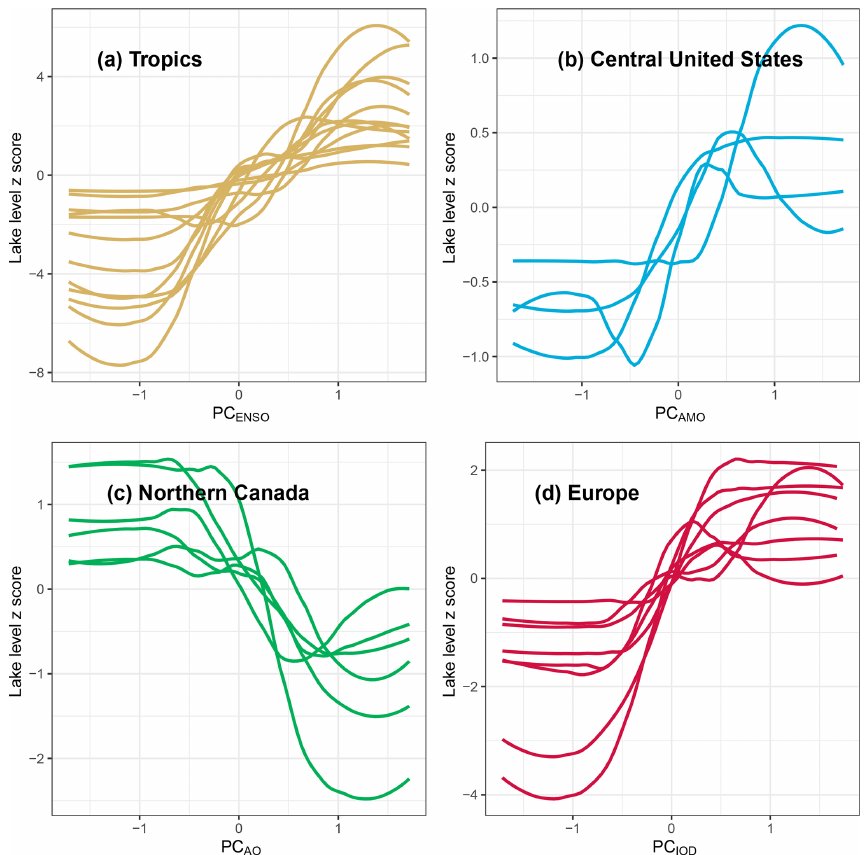
Figure 6. Regional consistency in the directionality of PC ENSO , PC AMO , PC AO , and PC IOD effects on water level variation. Each line represents a LOWESS-smoothed relationship between water level variation in a specific lake and one of the four PCs. Water levels have been transformed into z scores so that they may all be plotted on the same axis.